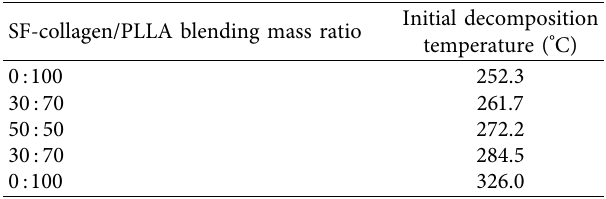
Table 4: Initial decomposition temperature of SF-collagen/PLLA composite nanofiber